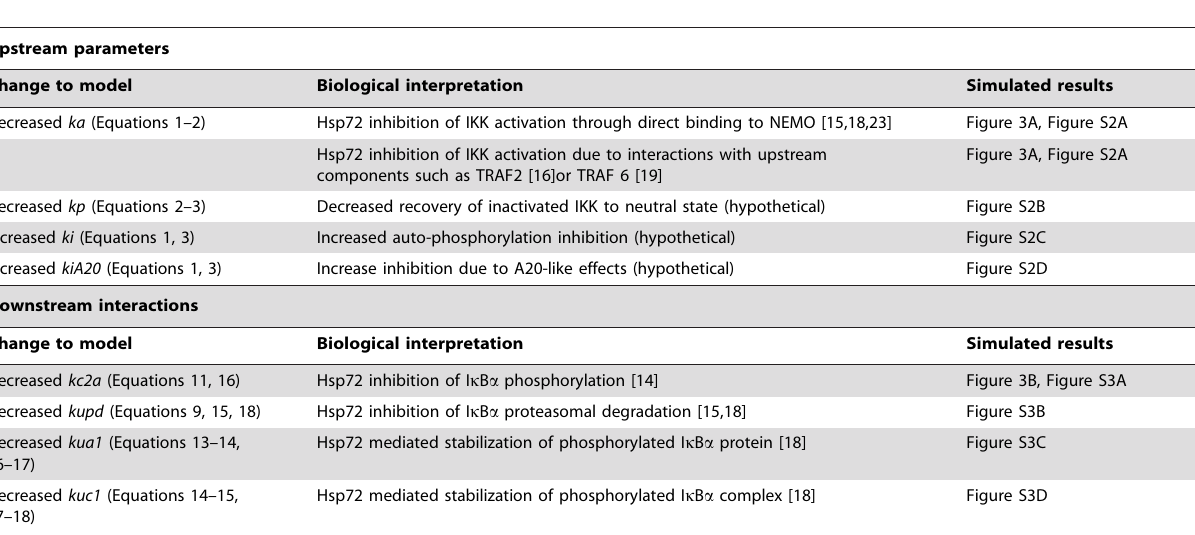
Table 1. Modifications to model parameters to simulate upstream and downstream regulatory interactions in the NF- k B signaling network.